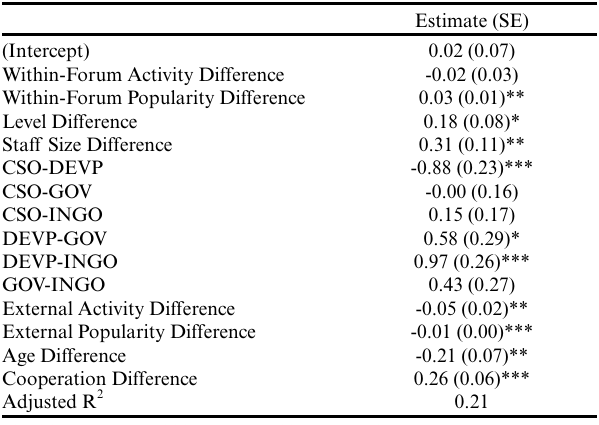
Table 1 . Regression model of the difference in perceived procedural fairness between organizations jointly participating in environmental policy forums. Note: CSO = civil society organizations; DEVP = development partners; GOV = governmental organizations; INGO = international nongovernmental